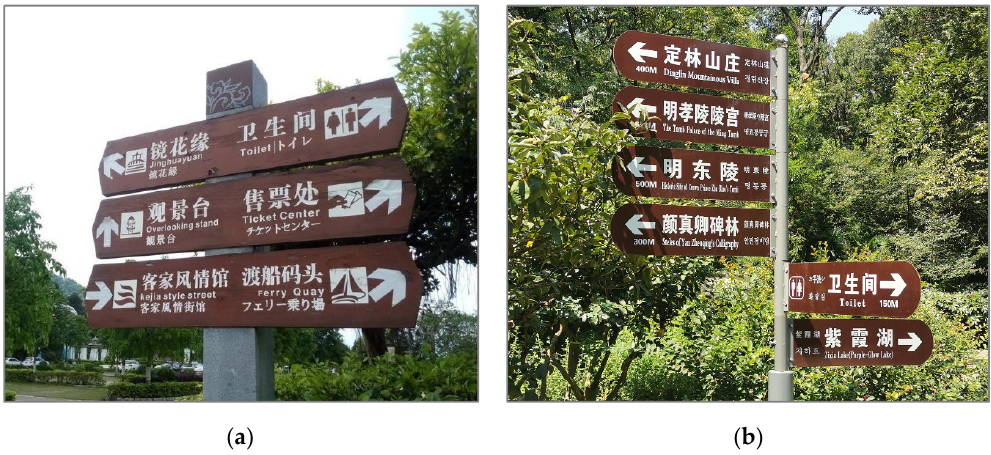
Figure 1. Examples of directional signs in a scenic area. ( a ) A directional sign with scenic spot name, representative graphic, and direction arrow; ( b ) A directional sign with scenic spot name, representative graphic, direction arrow, and travel distance.